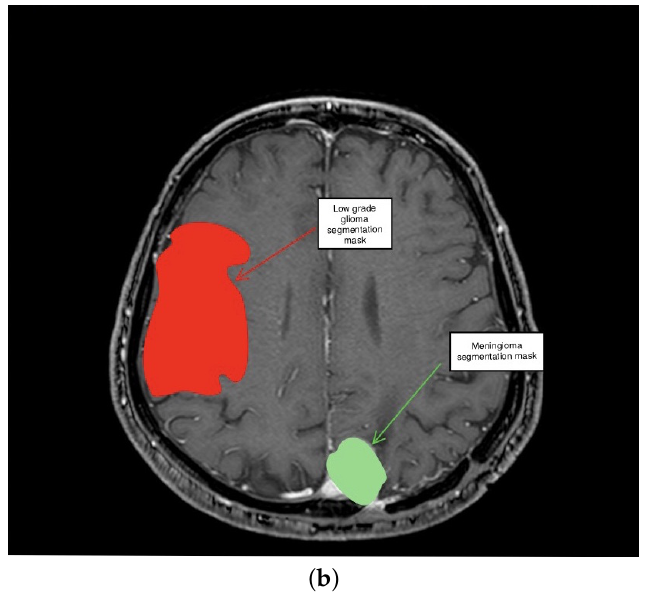
Figure 5. Experimental assessment, first patient. Segmentation with the proposed methodology ( a ) seeds localization, ( b ) results of the segmentation process, red area low grade tumor, green area